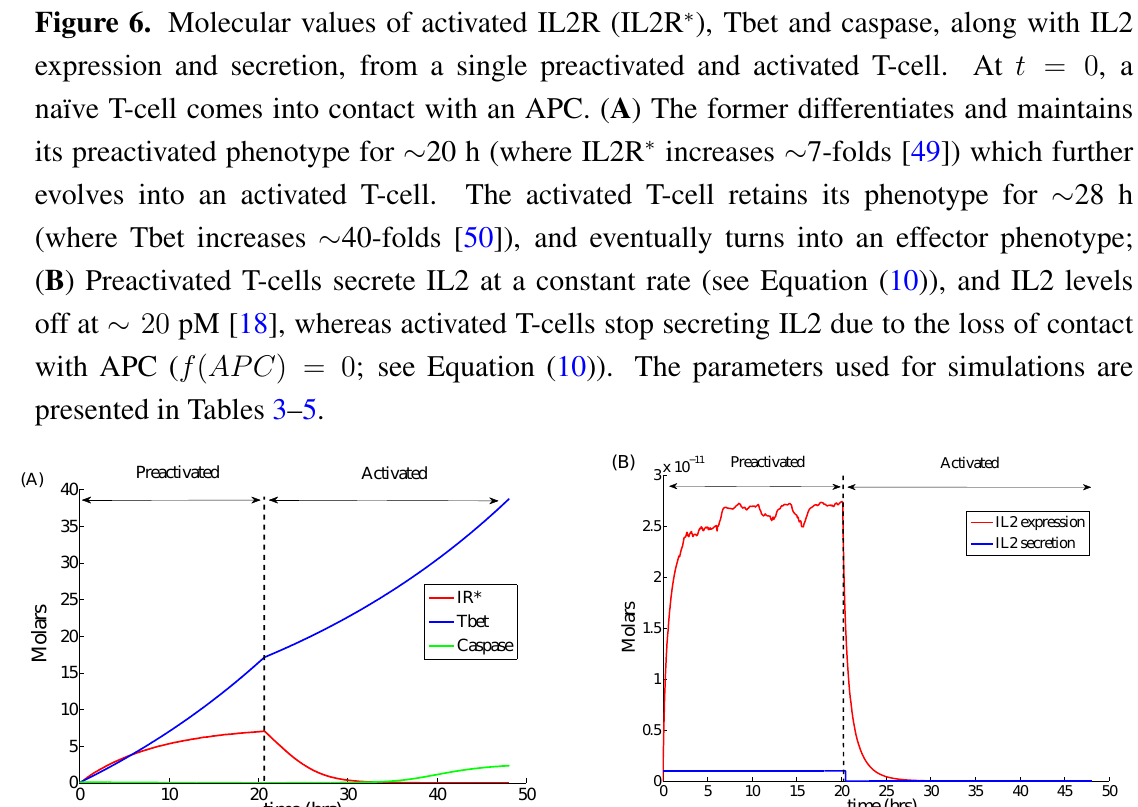
Figure 6. Molecular values of activated IL2R (IL2R ∗ ), Tbet and caspase, along with IL2 expression and secretion, from a single preactivated and activated T-cell. At t = 0 , a naïve T-cell comes into contact with an APC. ( A ) The former differentiates and maintains its preactivated phenotype for ∼ 20 h (where IL2R ∗ increases ∼ 7-folds [49]) which further evolves into an activated